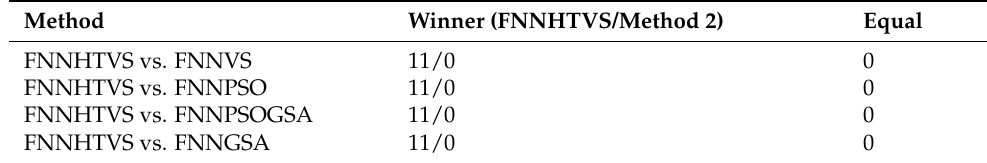
Table 5. WSR test results for the 3-bit parity problem.